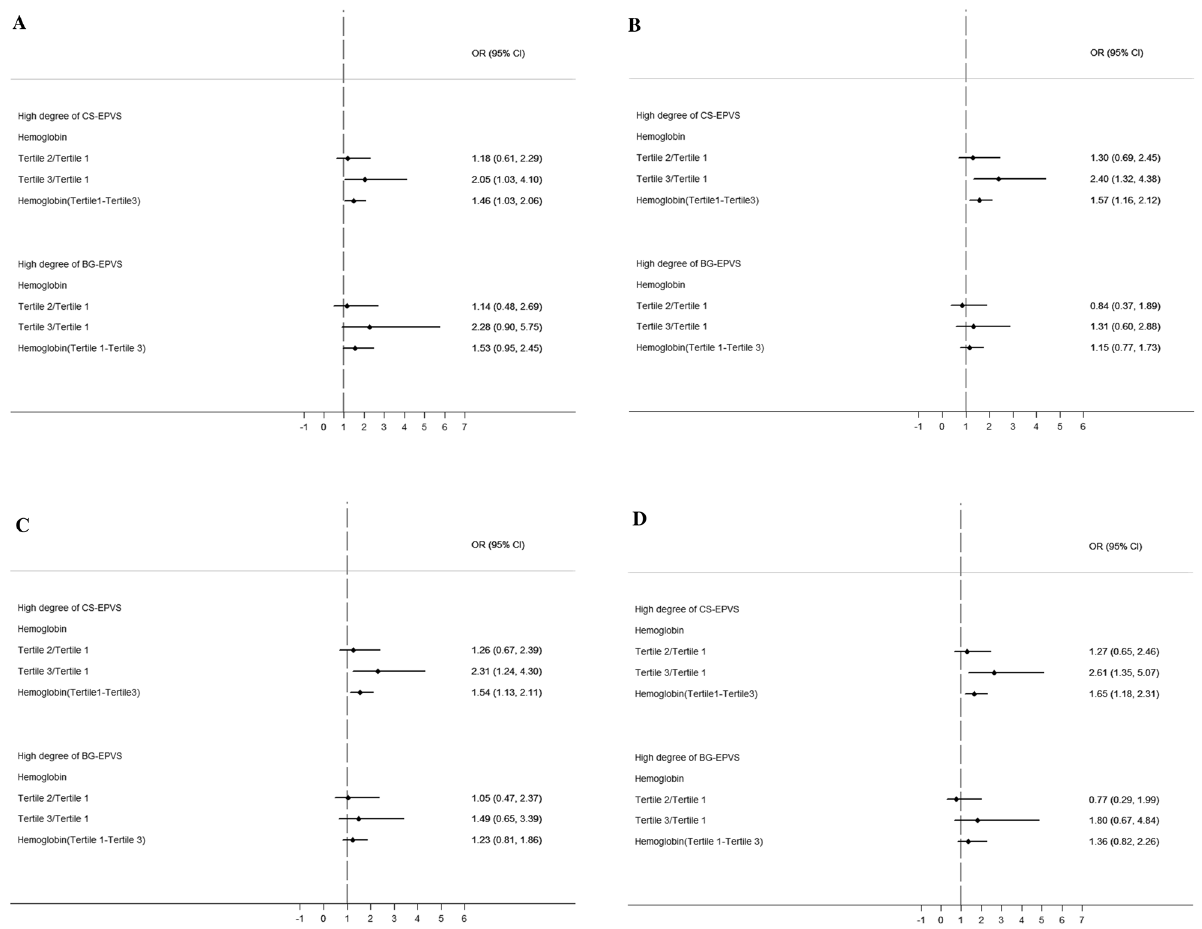
Figure 4. Associations between hemoglobin and high EPVS degree in BG and CS. Binary logistic regression was used to analyze these associations. ( A ) Adjusted for age and sex; ( B ) adjusted for lacune, PVWMH and DWMH; ( C ) adjusted for TC, TG and Apo B; ( D ) adjusted for BMI, hypertension, diabetes, hypercholesterolemia, coronary heart disease, current smoking, alcohol consumption, cerebral atrophy. BG basal ganglia, CS centrum semiovale, EPVS enlarged perivascular spaces, PVWMH periventricular white matter hyperintensities, DWMH deep white matter hyperintensities, BMI body mass index, TC total cholesterol, TG triglyceride, Apo B apolipoprotein B, OR odds ratio, CI confidence interval.